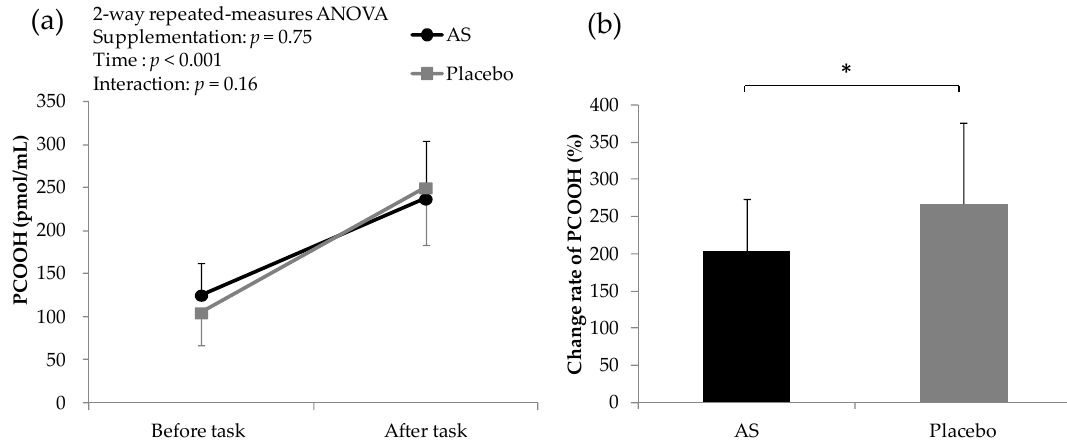
Figure 4. Concentration of PCOOH before and after fatigue-inducing tasks. ( a ) Change in PCOOH before and after task; ( b ) Change rate of PCOOH. * p < 0.05 between groups by paired t test. Data are presented as the means ± S.D.